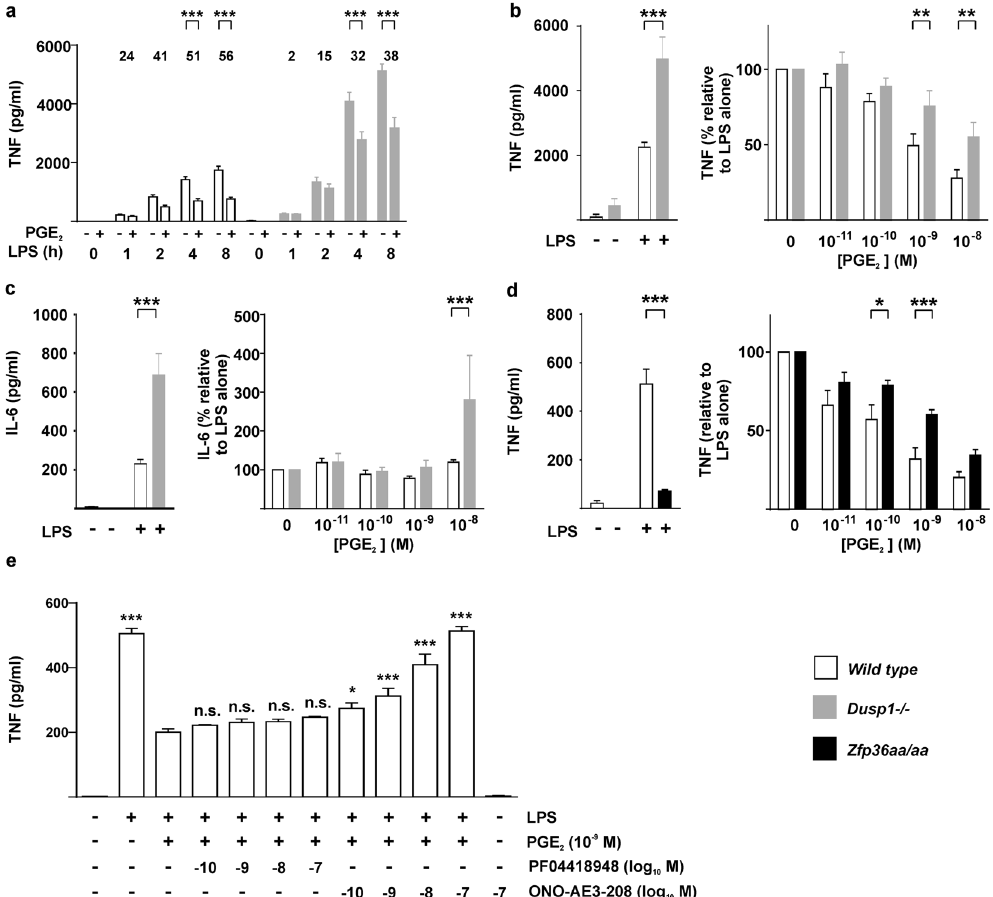
Figure 5. Anti-inflammatory effects of PGE 2 are gene-selective and partially dependent on DUSP1. ( a ) Dusp1 + / + and Dusp1 − / − BMMs were treated with 10 ng/ml LPS for the indicated times in the absence or presence of 1 nM PGE 2 , and TNF was measured by ELISA. The graph shows mean ± SEM of three independent BMM cultures of each genotype. The numbers above the graph indicate percentage inhibition of TNF release by PGE 2 . *** p < 0.005; Holm-Sidak method for multiple comparison. ( b ) Dusp1 + / + and Dusp1 − / − BMMs were treated with 10 ng/ml LPS for 4 h in the presence of increasing concentrations of PGE 2 , and TNF was measured by ELISA. The graph on the left illustrates absolute quantities of TNF. In the right hand graph, the quantity of TNF in the absence of PGE 2 is normalized to 100% for each genotype to illustrate differences in the effects of PGE 2 . Mean absolute or relative quantities of TNF from six independent BMM cultures of each genotype are plotted, ± SEM. ** p < 0.01; *** p < 0.005; Holm-Sidak method for multiple comparison. ( c ) As ( b ), except that IL-6 was measured. *** p < 0.005. ( d ) As ( b ), except that the comparison was between Zfp36 + / + and Zfp36aa/aa BMMs, and n = 3. * p < 0.05; *** p < 0.005; Holm- Sidak method for multiple comparison. ( e ) Wild type BMMs were treated with 10 ng/ml LPS in the absence or presence of 1 nM PGE 2 and the indicated concentrations of PF04418948 (( a ) specific EP2 antagonist) or ONO-SE3-208 ( a ) specific EP4 antagonist). TNF was measured by ELISA. The graph represents mean TNF concentration ± SEM from three independent BMM cultures. All statistical comparisons are against the third column, in which BMMs received both LPS and PGE 2 . n.s., not statistically significant; * p < 0.05; *** p < 0.005;